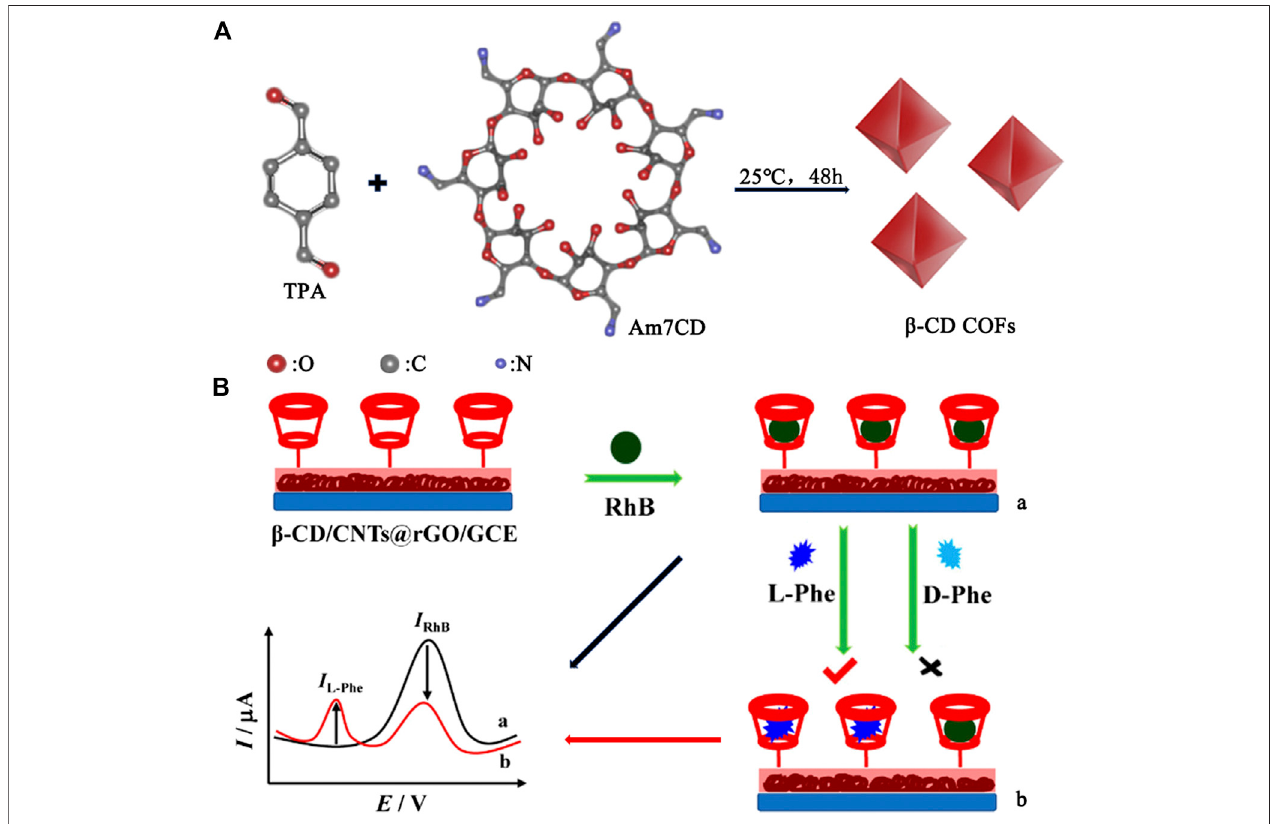
FIGURE 2 | (A) The preparation of the chiral stationary phase: β -CD COFs. (B) The electrochemical sensor platform for recognition chiral phenylalanine enantiomers.